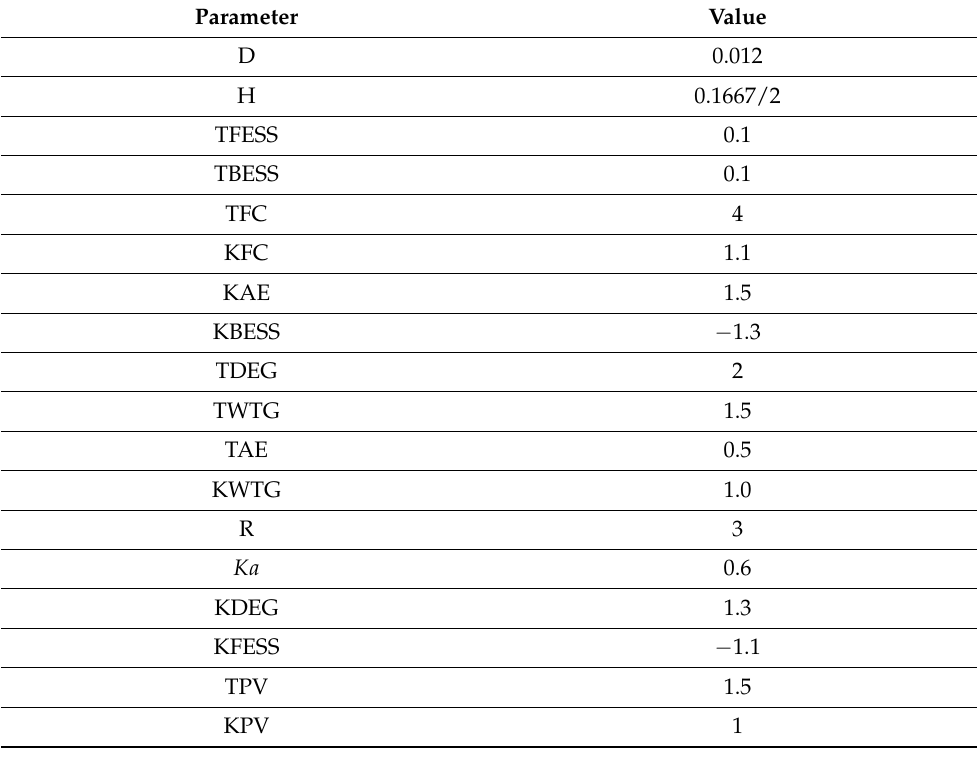
Table 1. Parameters of the microgrid’s power sources [55,56].